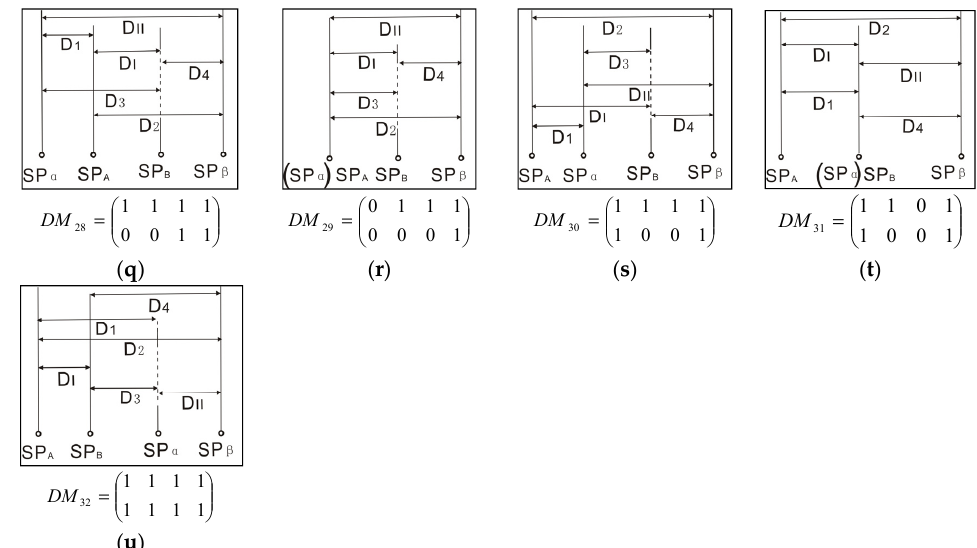
Figure A1. The DS8DMs between the SGRPMs. ( a )–( u ) depict the 21 DS8DMs between the SGRPMs.